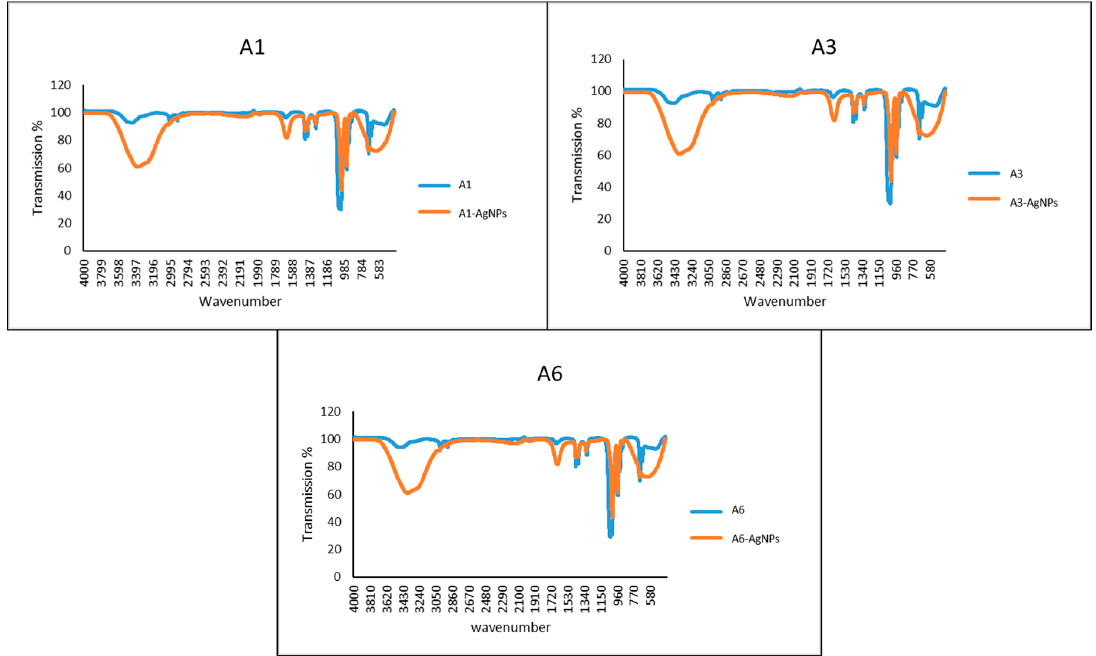
Figure 6. FT-IR spectrum of azoles before and after conjugation with silver nanoparticles. Changes can be seen in the peaks before and after conjugation with silver-nanoparticles, suggesting successful conjugation of drugs and nanoparticles.